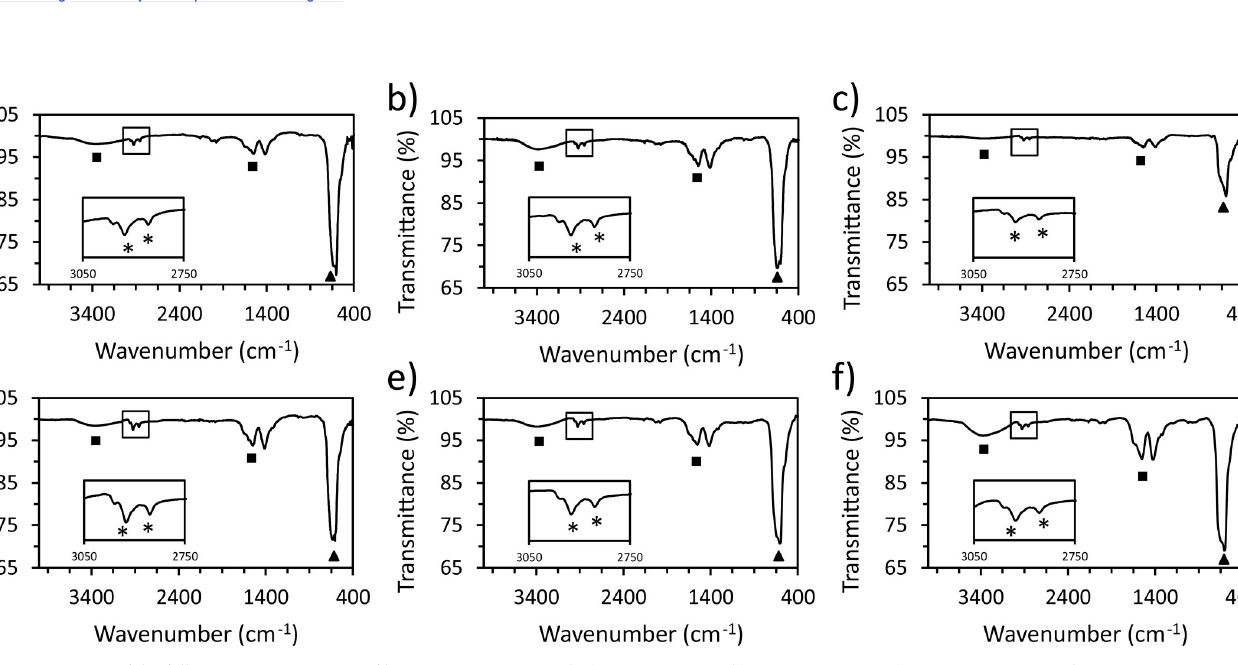
PLOS ONE | https://doi.org/10.1371/journal.pone.0239034 September 18,